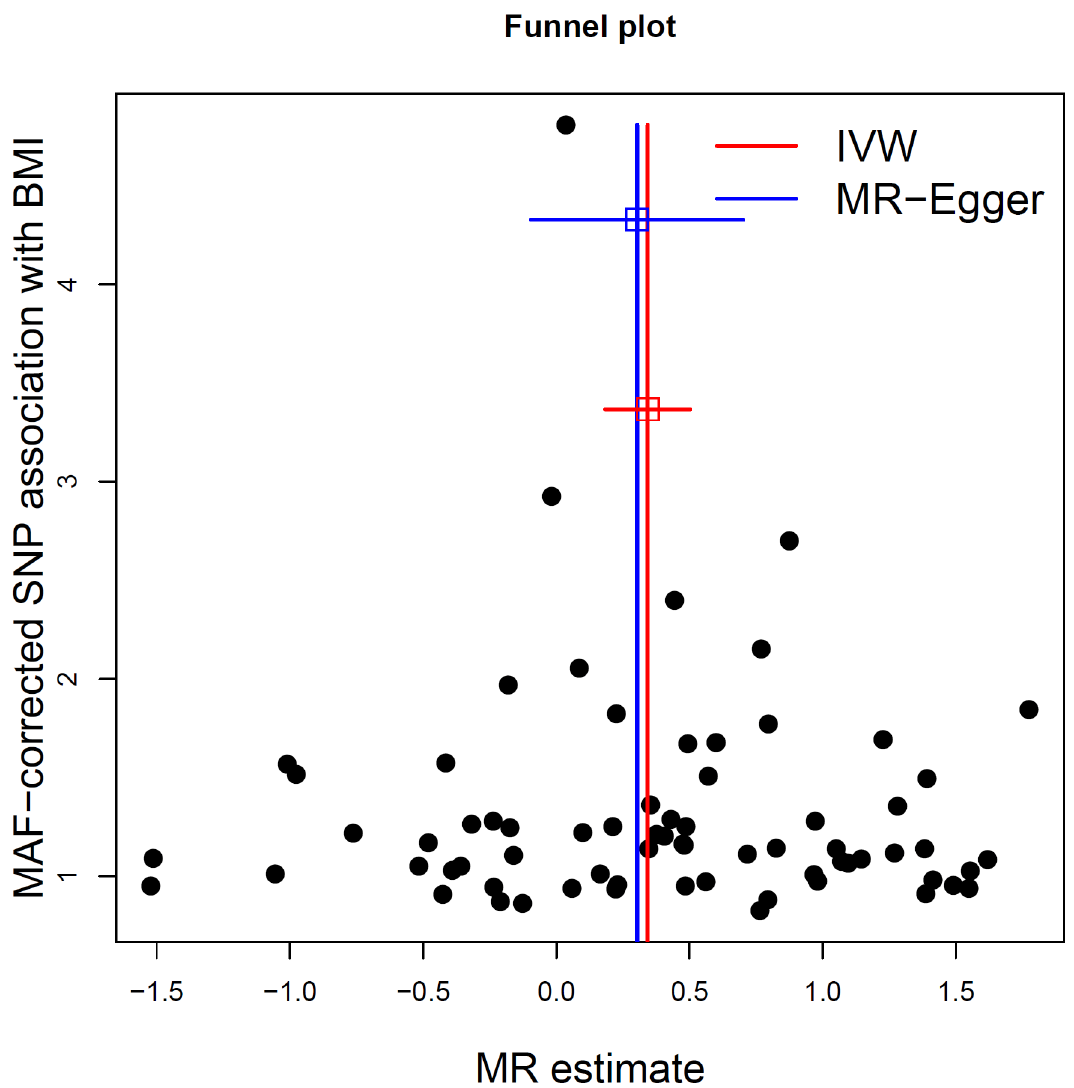
Fig 3. MR-Egger regression funnel plot for BMI on MS analysis. Each SNP ’ s MR estimate is plotted against its minor- allele frequency corrected association with BMI. A minor allele frequency (MAF) correction proportional to the SNP-BMI standard error is used since a low-frequency allele is likely to be measured with low precision. Similar to the use of funnel plots in the meta-analysis literature, this plot can be used for visual inspection of symmetry, where any deviation can be suggestive of pleiotropy. We note that our plot appears generally